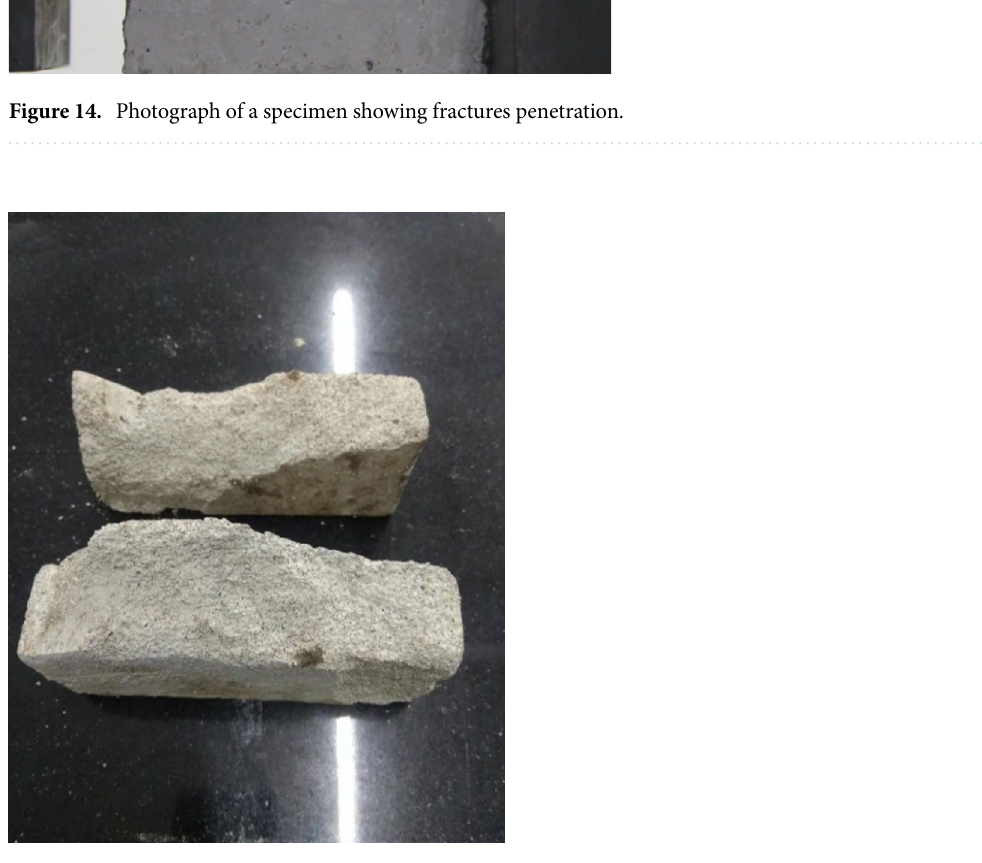
Figure15. The shear fracture surface of the